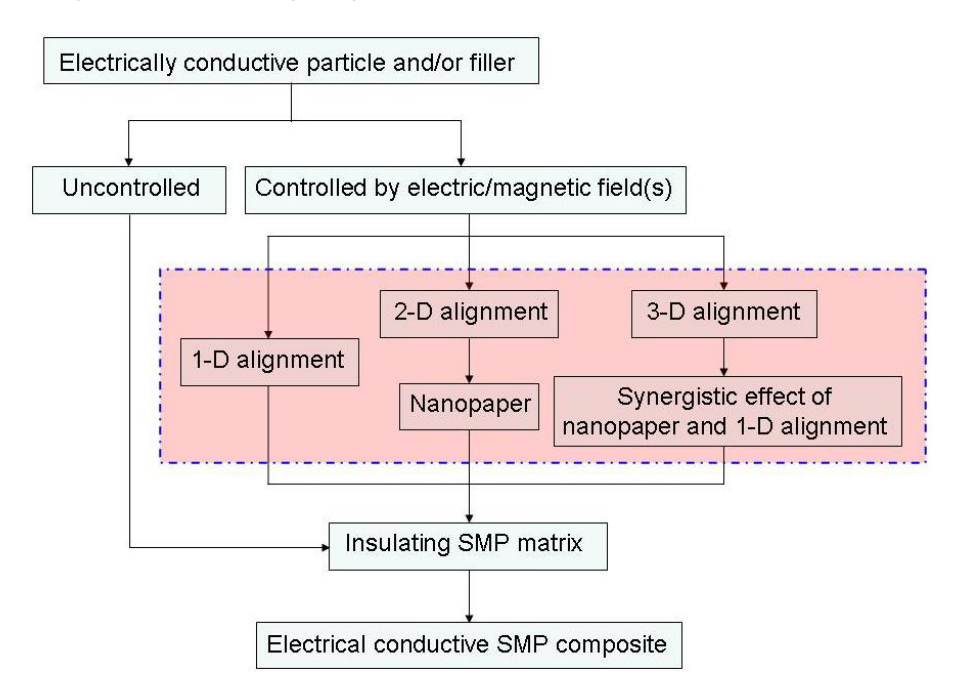
Figure 1. An initial diagram showing the mechanism of actuation via electrically resistive Joule heating of shape-memory polymer (SMP)